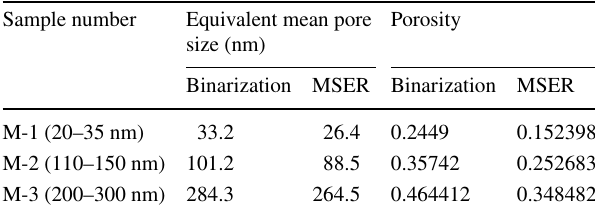
Table 1 Characterization result parameters of anodic aluminum membranes Sample